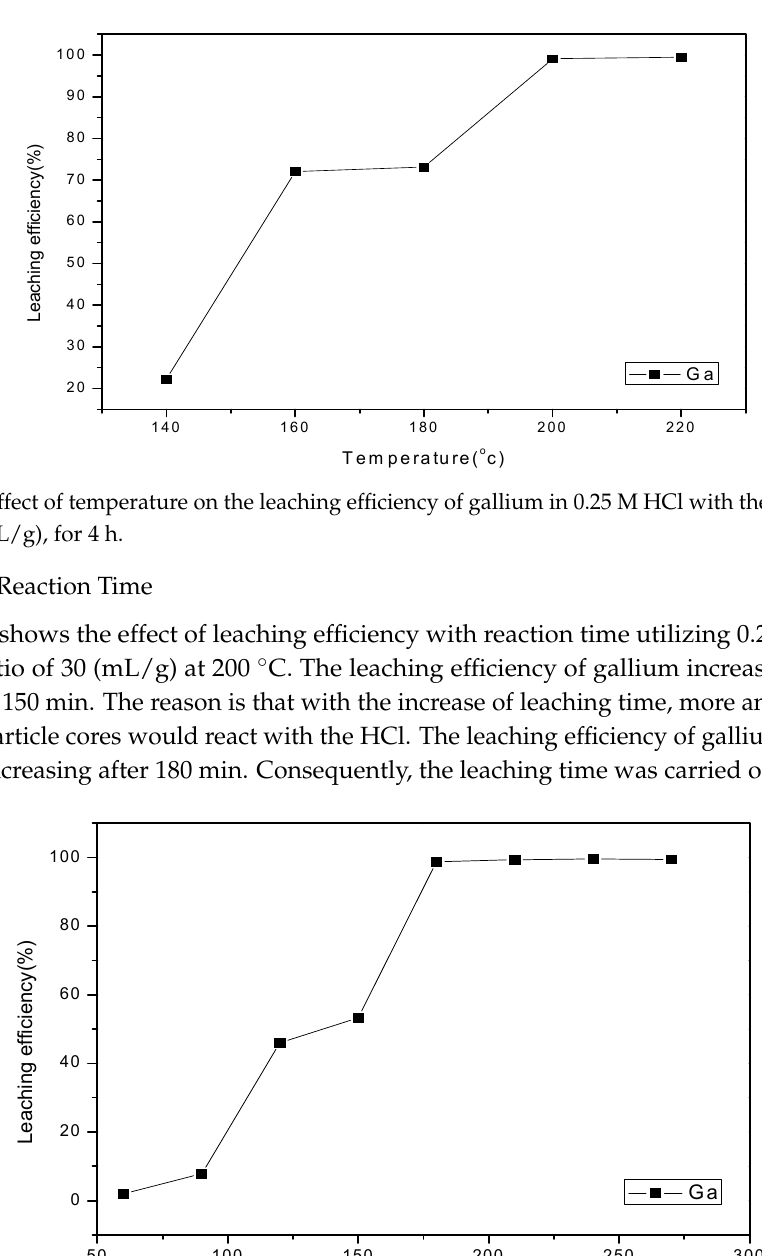
Figure 8. Effect of liquid/solid ratio on the leaching efficiency of gallium in 0.25 M HCl at 220 °C for 4 h.